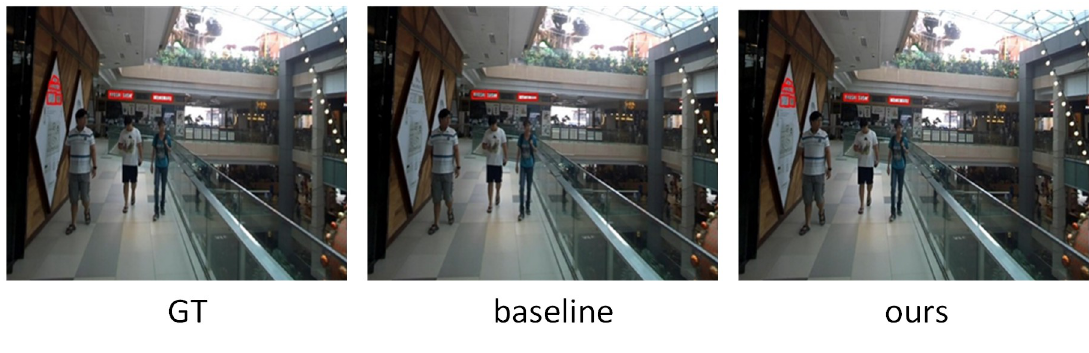
Fig 11. The visualization results of GT, baseline and our method on